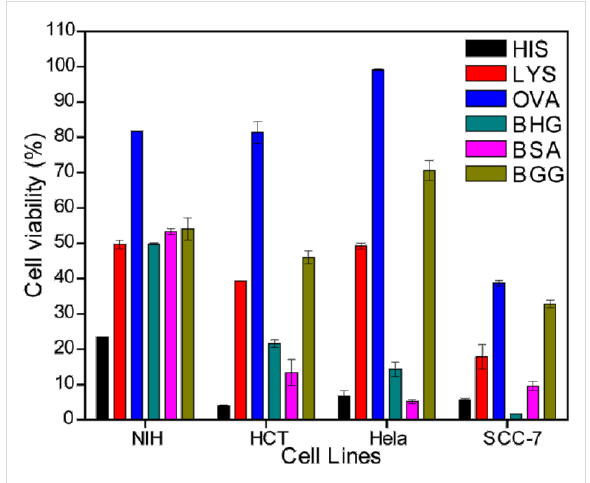
Figure 6: Plot representing cell viability of AuNPs prepared by using different proteins vs different cell lines at 60 µg/mL concentration of the AuNPs studied using MTT